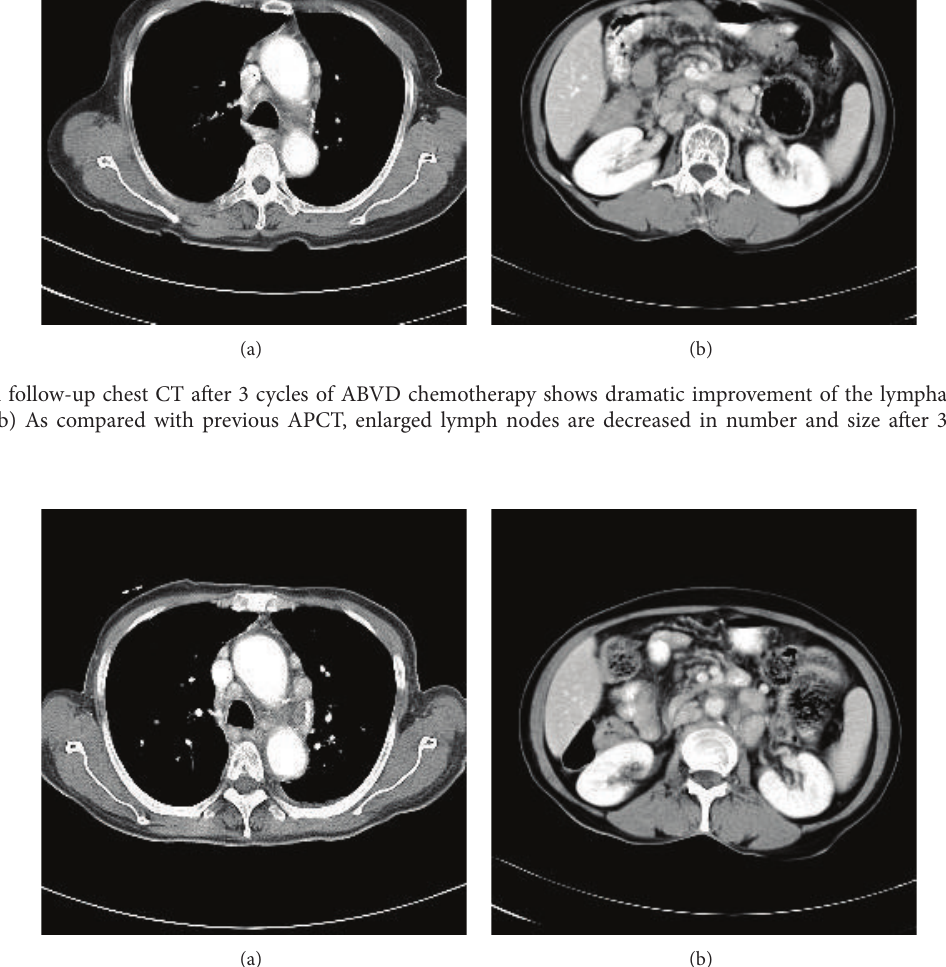
Figure 4: A chest CT (a) and an AP CT (b) show increased sizes of lymph nodes on mediastinum and retroperitoneal space after 12 months of follow-up